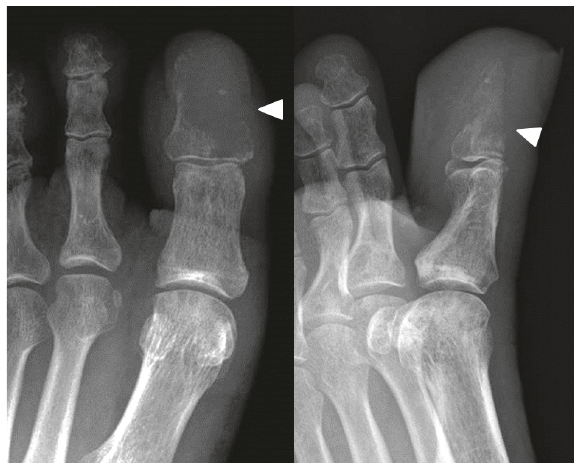
Figure 1: Plain radiographs of the left foot show destruction of the first distal phalanx.